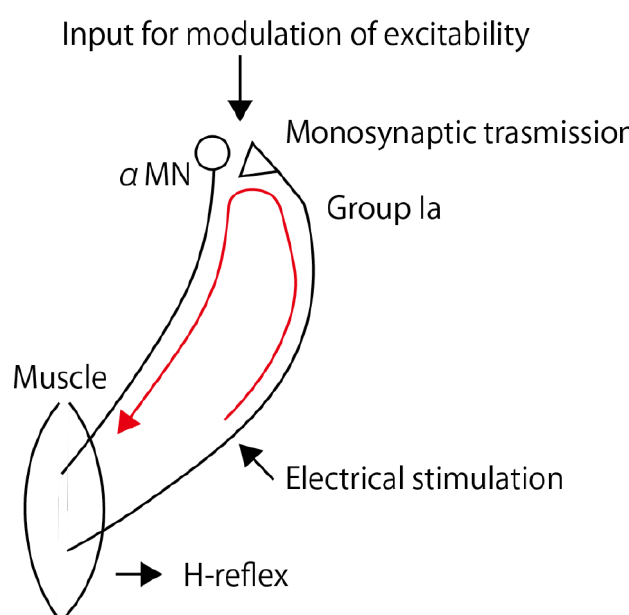
Figure 3. Circuit of the H-reflex. Electrical stimulation elicits an action potential in the group Ia afferent fibers of the sensory nerve. These ascending potentials activate the alpha motoneurons ( αMN ) in the spinal anterior horn through a monosynaptic pathway, ultimately inducing a single muscle twitch. This particular response is commonly referred to as the Hoffman reflex (H-reflex).